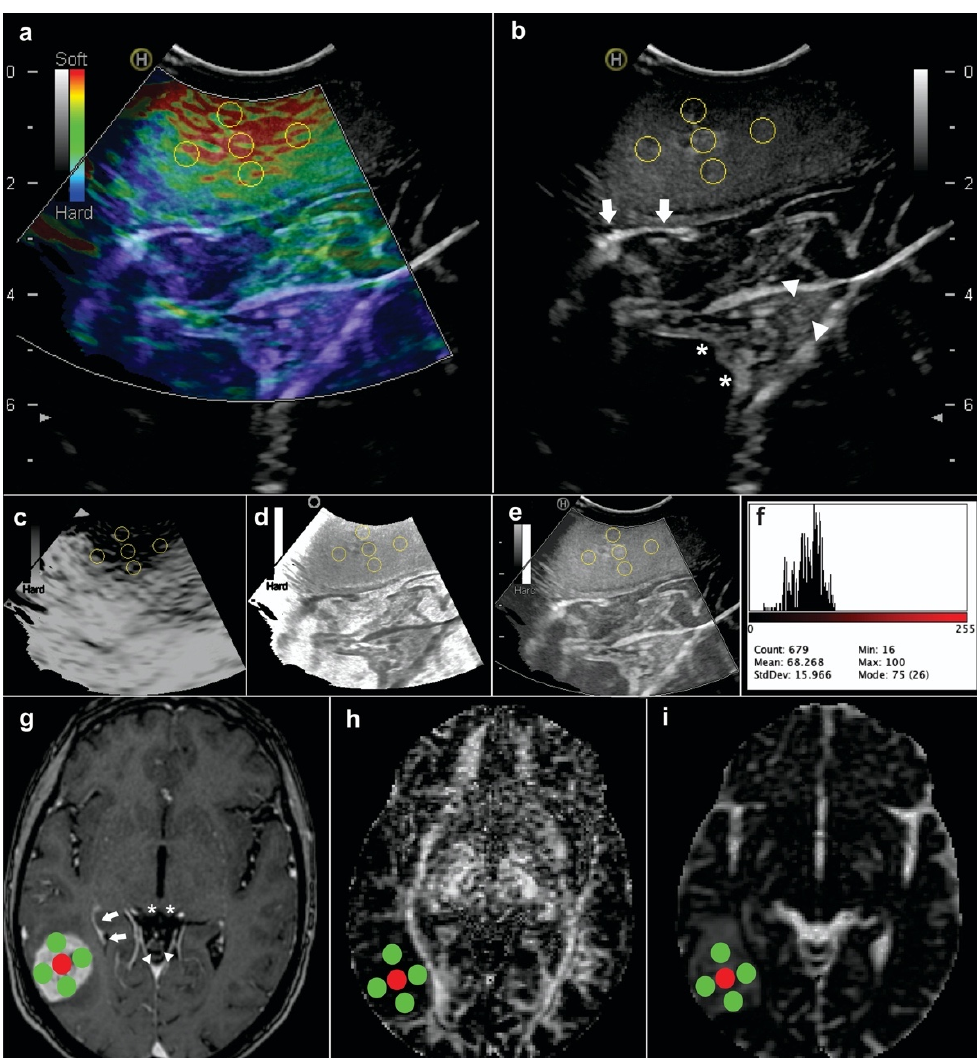
Figure 2. Illustrative case showing the methodology applied for image analysis. Images correspond to a 72-year-old woman with a right parieto-occipital glioblastoma. Regions of interest (ROIs) were placed in the central/core and peripheric tumor regions that were revealed using ( a ) elastograms and ( b ) B-mode images. Ultrasound (US) images were decomposed into a hue-saturation-brightness (HSB) type: ( c ) hue; ( d ) saturation; and ( e ) brightness mode. ( f ) Mean tissue elasticity (MTE) values were calculated using histogram intensity analysis. ( g ) The axial T1-post contrast image was selected based on anatomical references: Inferior colliculus (white asterisk); occipital horn of lateral ventricle (white arrows); and cerebellar vermis (white head arrows). These structures were also visualized in US images. Tumoral values were calculated using diffusion maps of the ( h ) fractional anisotropy and ( i ) mean diffusivity.